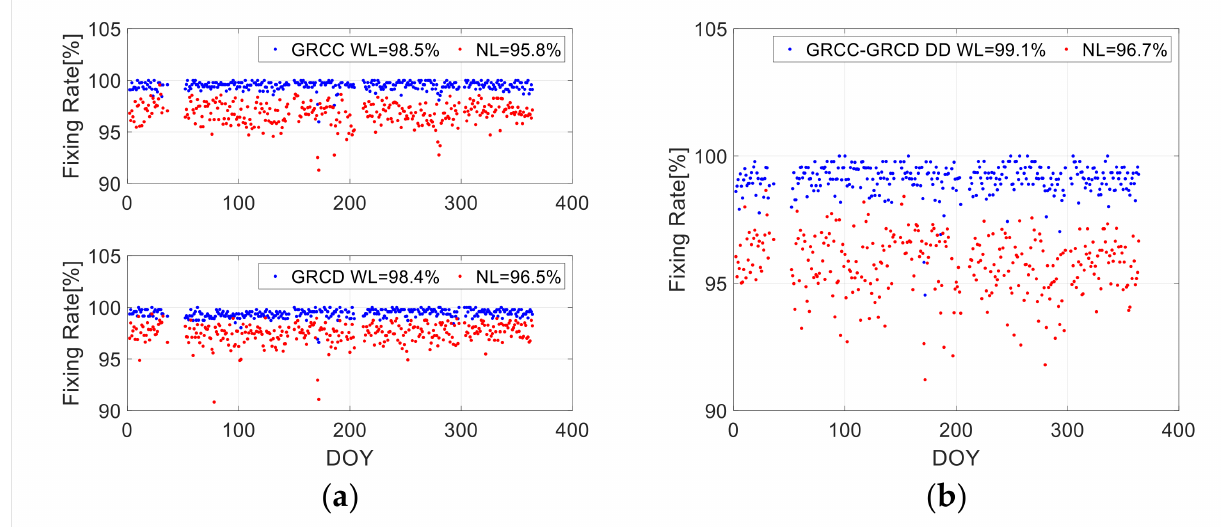
Figure 6. Fixing rates of ( a ) SD WL and NL ambiguities of GRCC and GRCD satellites and ( b ) DD WL and NL